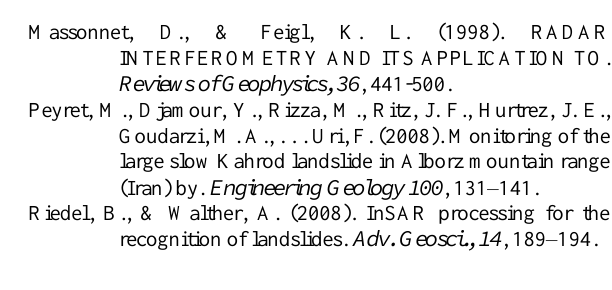
Fig 6 Deformation time-series of selected points. (a) Deformation time-series of selected points spanning between 2006/09/24 and 2007/08/05. (b) Deformation time-series of selected points spanning between 2007/09/09 and